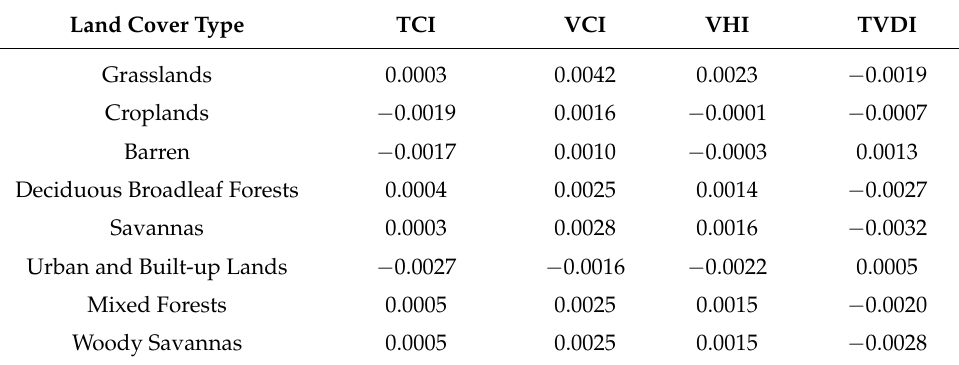
Table 9. Statistic of p -Value in different land cover types.